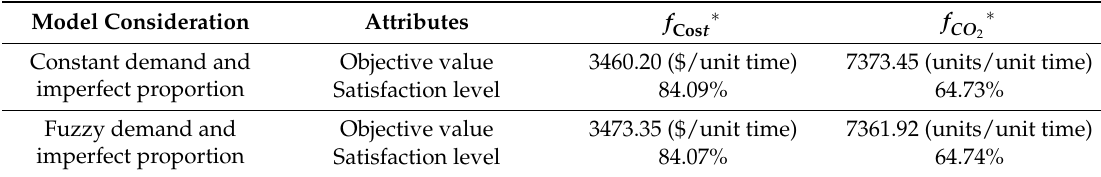
Table 4. Optimal results of multi-objectives.